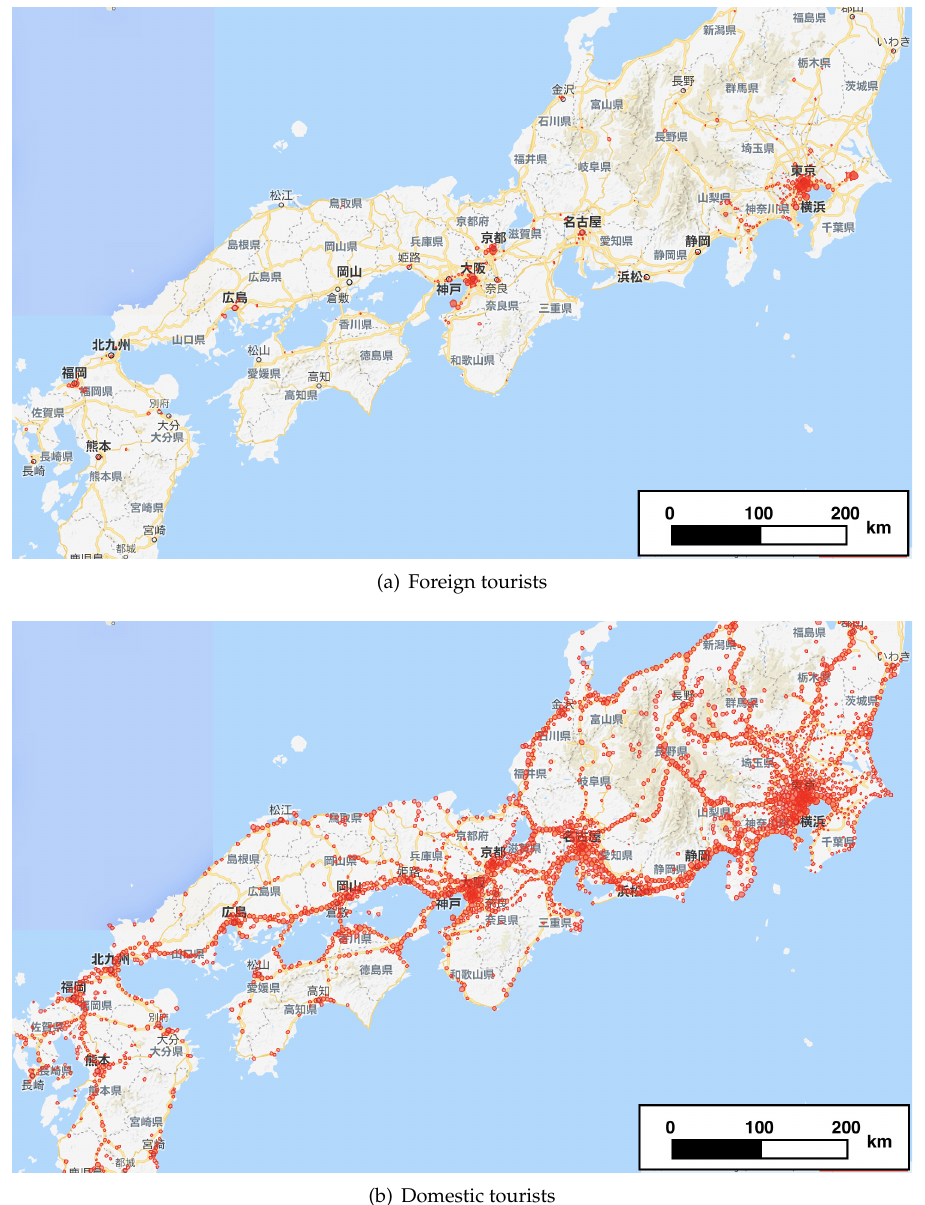
Figure 5. Spatial distributions of the numbers of tourists: The spatial convergence of foreign tourists is much higher than that of domestic